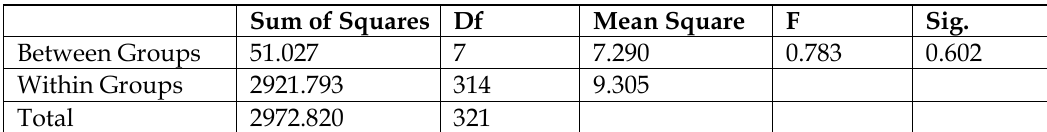
Table 9a: One-way ANOVA test for academic disciplines ANOVA USMPP Sum of Squares